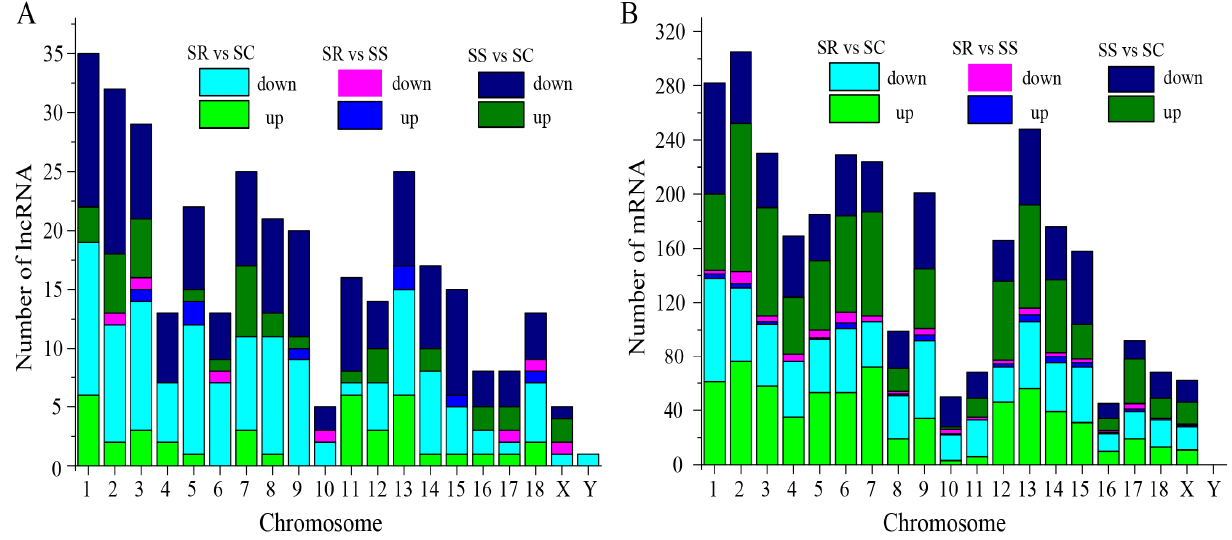
Figure 2. Distributions of DE lncRNAs and mRNAs in pig chromosome. The x -axis indicates different